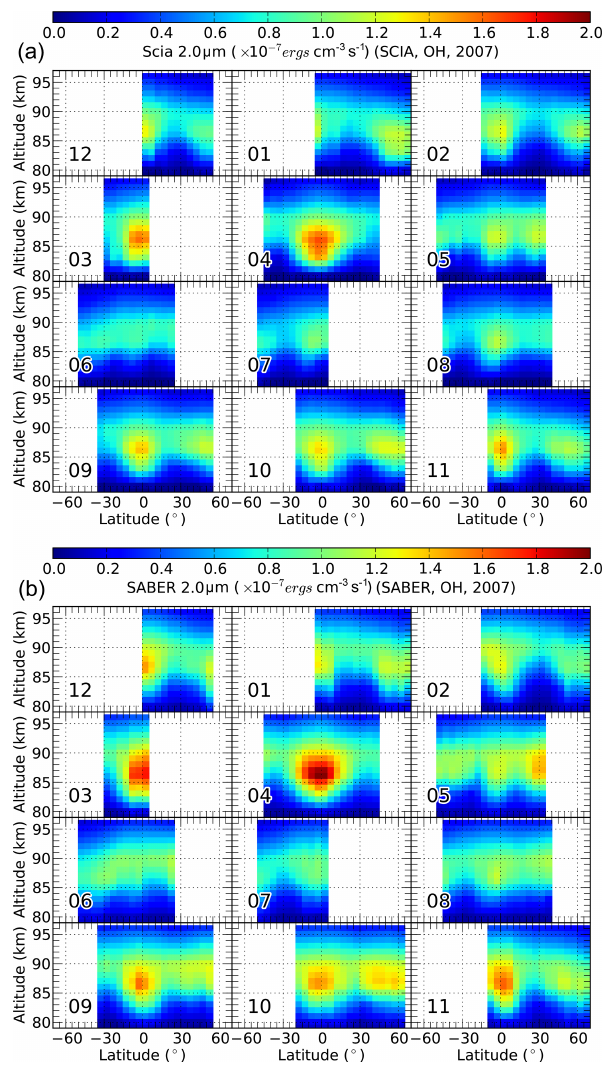
Figure 5. Latitude–altitude cross sections of monthly zonal me- dian SABER unfiltered 2.0µm volume emission rates (b) and cor- responding simulations (a) from SCIAMACHY data for the year 2007. The numbers represent the month of the